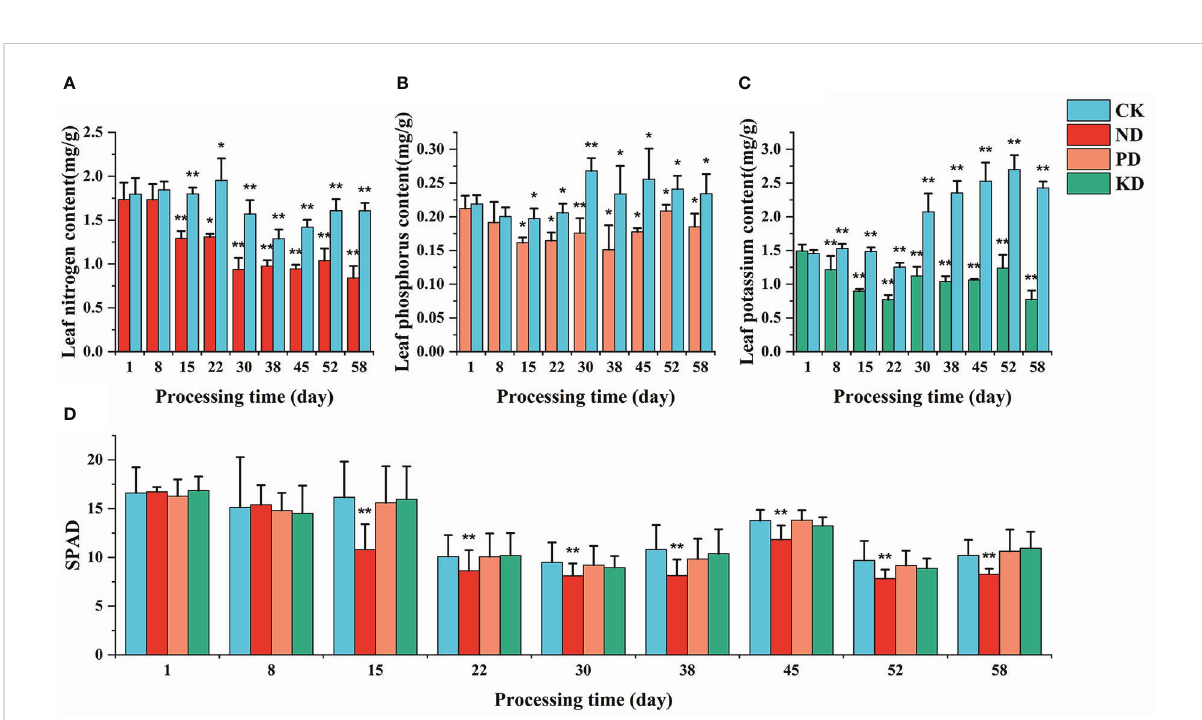
FIGURE 8 Chemical diagnosis and SPAD diagnosis results. (A) Leaf N content. (B) : leaf P content. (C) leaf K content. (D) SPAD values; * (P<0.05) and ** (P<0.01) represent signi fi cant differences from the control group. Statistical methods used were Student ’ s t-test and